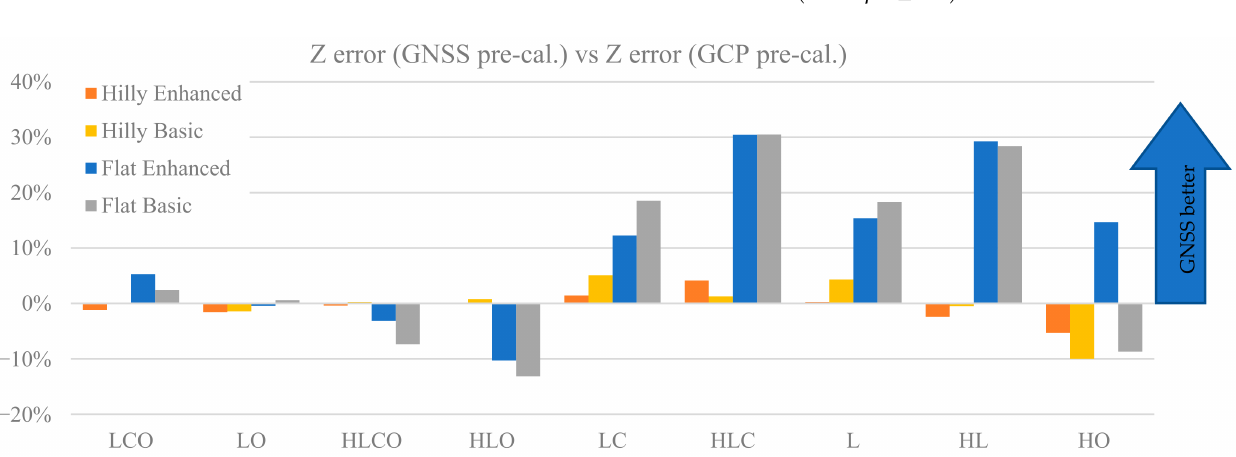
Figure 12. Percentage Z error difference on check points for blocks pre-calibrated with camera parameter sets estimated with GNSS-determined camera stations or GCP. Percentages are shown as a function of the nine cases of the terrain type (Flat, Hilly) and of the control tightness (Basic or Enhanced). Positive values mark comparatively smaller Z errors for GNSS w.r.t GCP and vice versa for negative